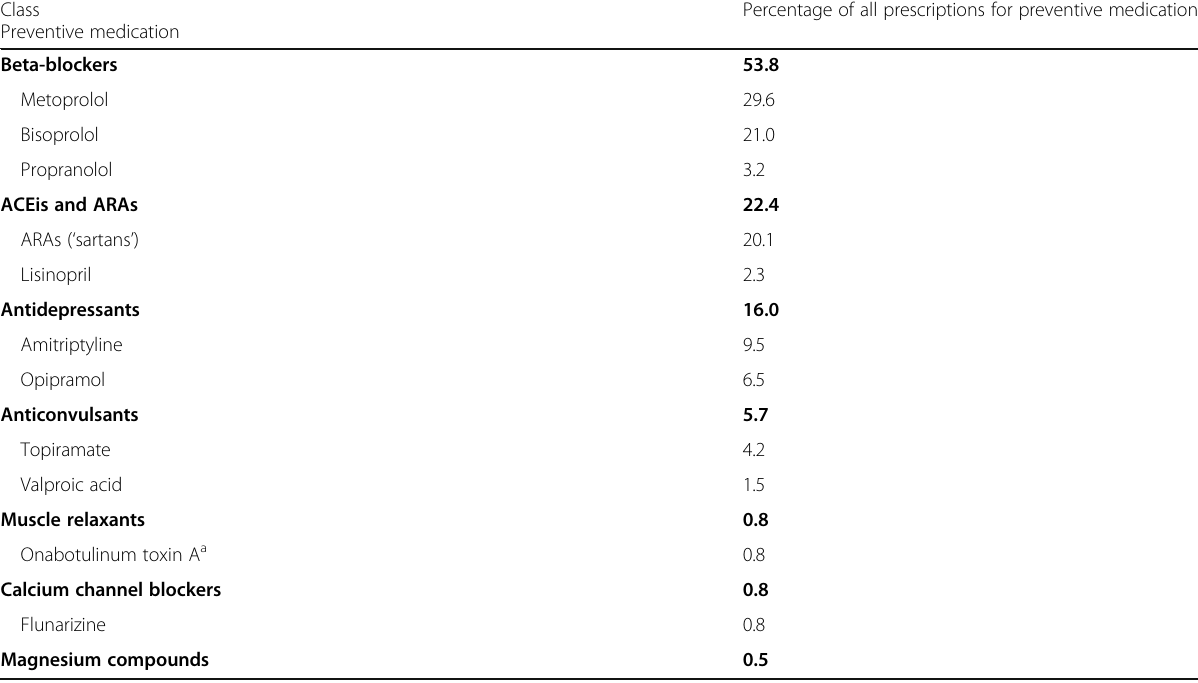
Table 3 Prescribed in- and off-label (Group 2) preventive medications for patients with migraine in the German Company Sickness Fund Database 2016